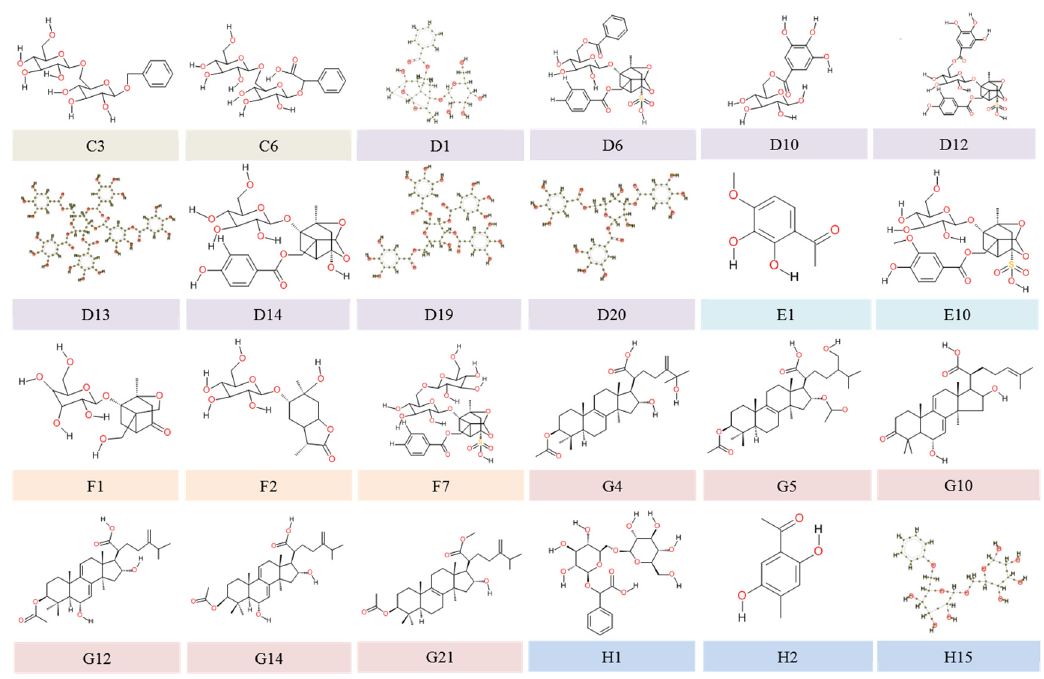
Figure 2. Molecular structures of the 24 chemical constituents of Guizhi Fuling Wan. Note: C3: Benzol- β -gentiobioside, C6: Mandelic acid gentiobioside/isomer, D1: 4 ′ -O-galloypaeoniflorin, D6: Benzoylpaeoniflorin sulfate, D10: Galloyglucose/isomer, D12: Galloylpaeoniflorin sulfonate, D13: Hexagalloyl glucose, D14: Isoxypaeoniflora, D19: Tetragalloy glucose, D20: Trigalloy glucose, E1: 3-hydroxypaeonol, E10: Mudanpioside E sulfonate, F1: 1-O- β - D -glucopyranosyl-paeonisuffrone, F2: 6-O- β - D -glucopyranosyl lactinolide, F7: Isomaltopaeoniflorin sulfonate, G4: 25-Hydroxypachymic acid, G5: 31-Hydroxyl-16-O-acetylpachymic acid, G10: 3-oxo-6,16 α -dihydroxy-lanosta-7,9(11),24(31)-trien-21-oic acid, G12: 3 β ,16 α -Dihydroxy-lanosta-7,9(11),24-trien-21-oic acid, G14: 6 α -Hydroxydehydropachymic acid, G21: Pachymic acid methyl ester, H1: (2R)-[(6-O- β - d -glucopyranosyl- β - d -glucopyranosyl) oxy] (phenyl) ethanoic acid, H2: 2,5-dihydroxy-4-methylacetophenone, H15: Benzyl- β - D -glucopyranosyl-(1 → 6)- β - D -glucopyranoside.